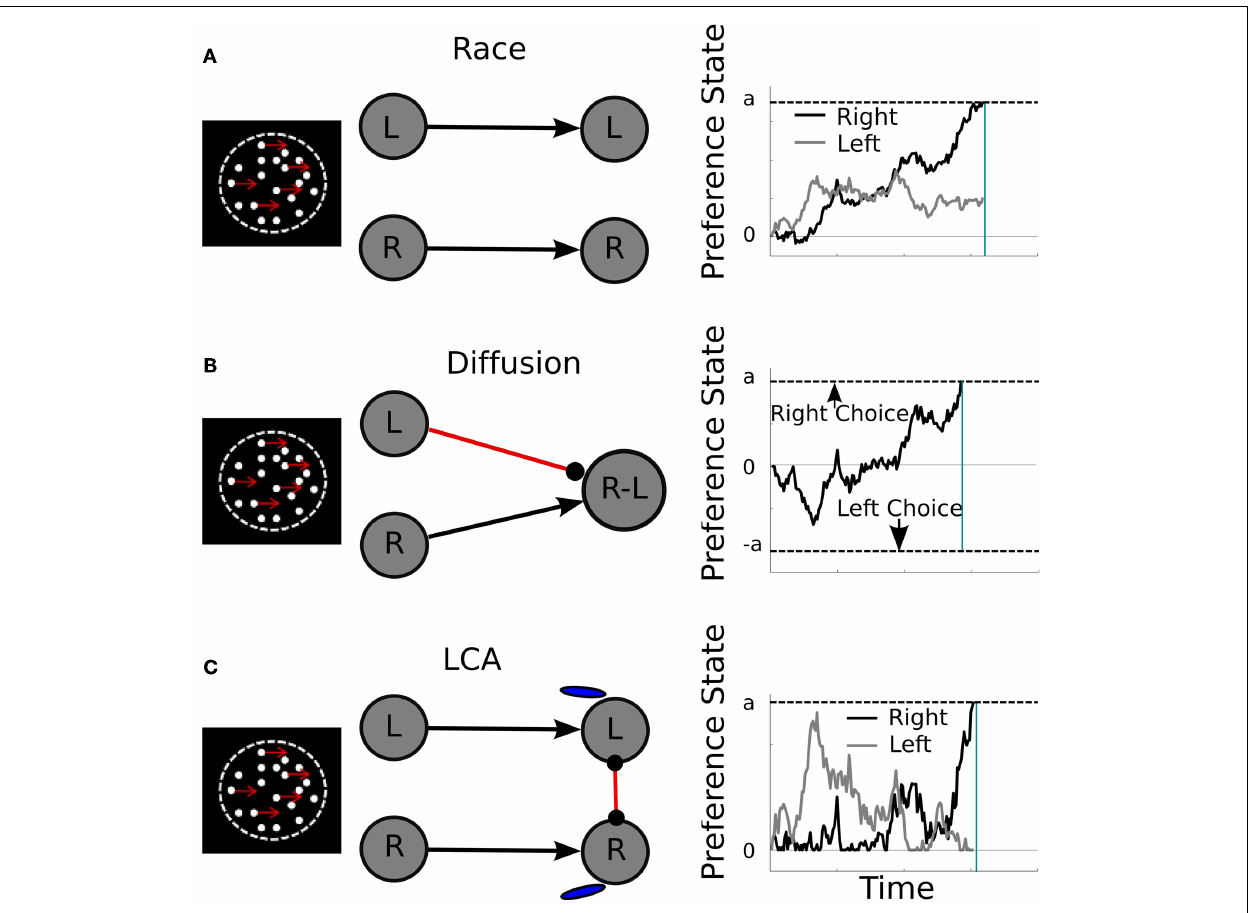
(black) units, or a unit encoding their difference of activation (black, part B only). Bounds on activation level, at which a choice is initiated, are indicated by the dashed line signaled with lowercase letter a (or – a, part B only). Vertical cyan line, estimated reaction time for the representative trial. In the race model, the two options race independently toward a common upper decision boundary. In the diffusion model, choice is determined by which boundary is first reached (upper or lower). In the LCA model, the two options compete against each other toward a common response